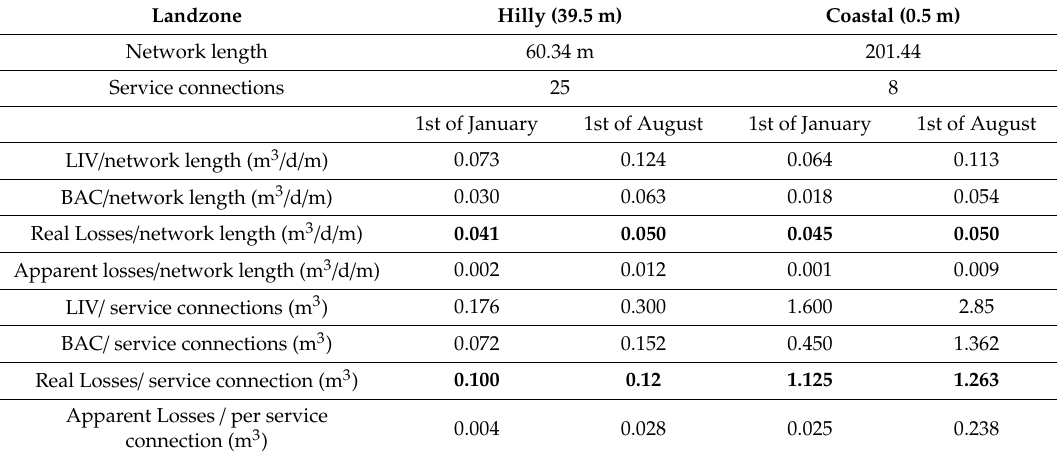
Table 5. The daily amounts of landzone input volumes (LIV), BAC, real losses, and apparent losses for two indicative landzones expressed in per-network-length and per-service-connection